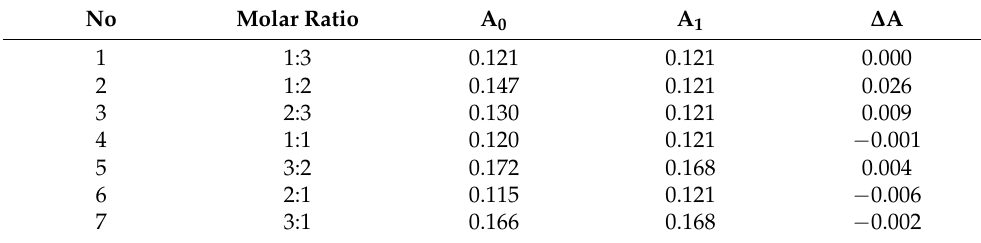
Table 2. Molar ratio experiments of RBG/HP- β -CD